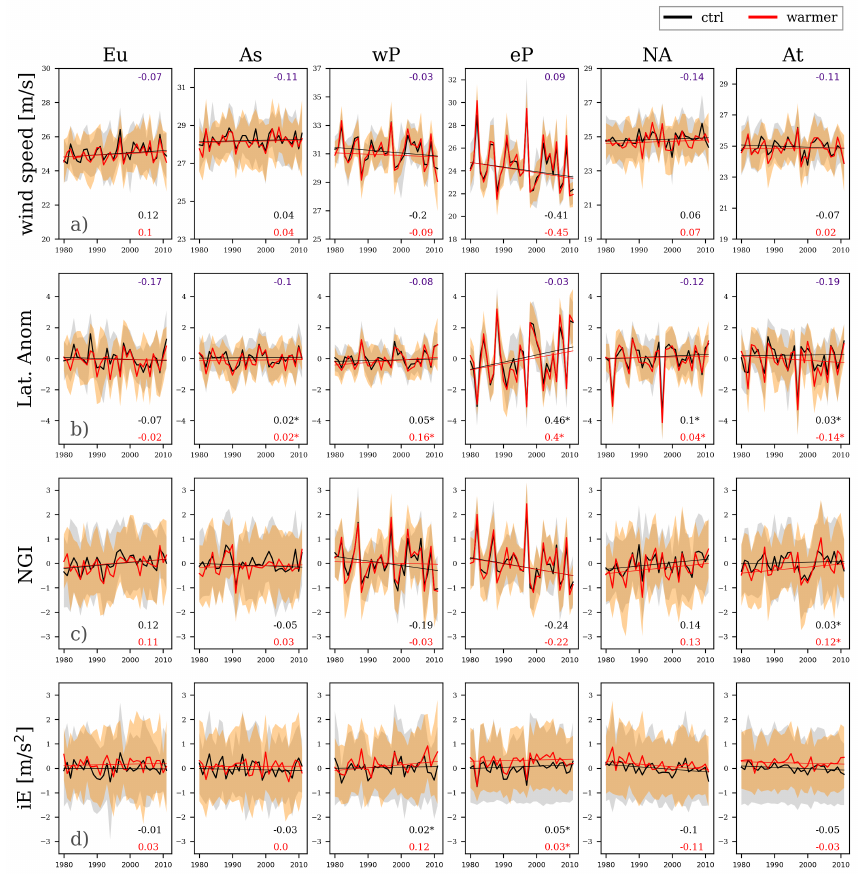
Figure 8. As in Figure 7, but for the SSTreal